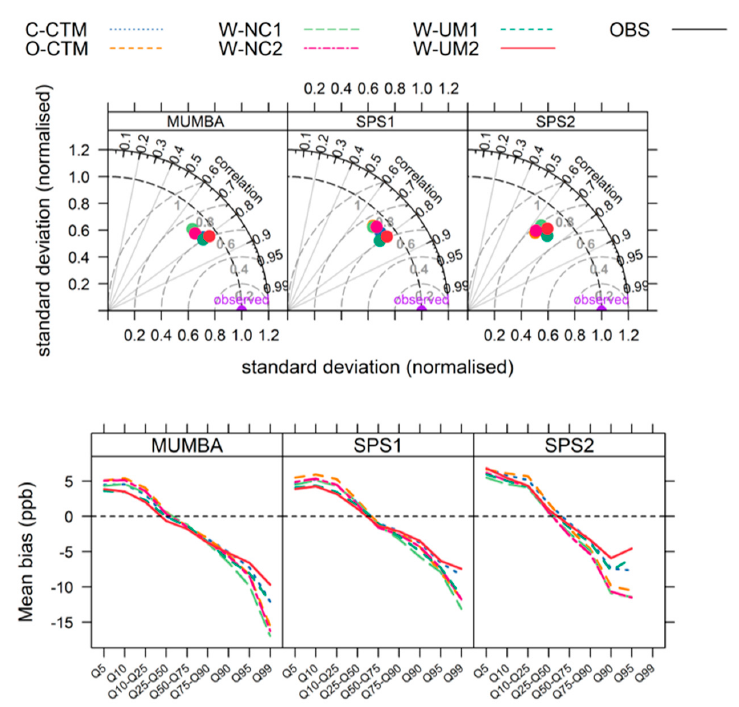
Figure A1. Composite diurnal cycles for observed and modelled hourly average NO x concentration in ppb during each campaign (upper panel) and Taylor diagrams for hourly NO x from each campaign period (lower panel).